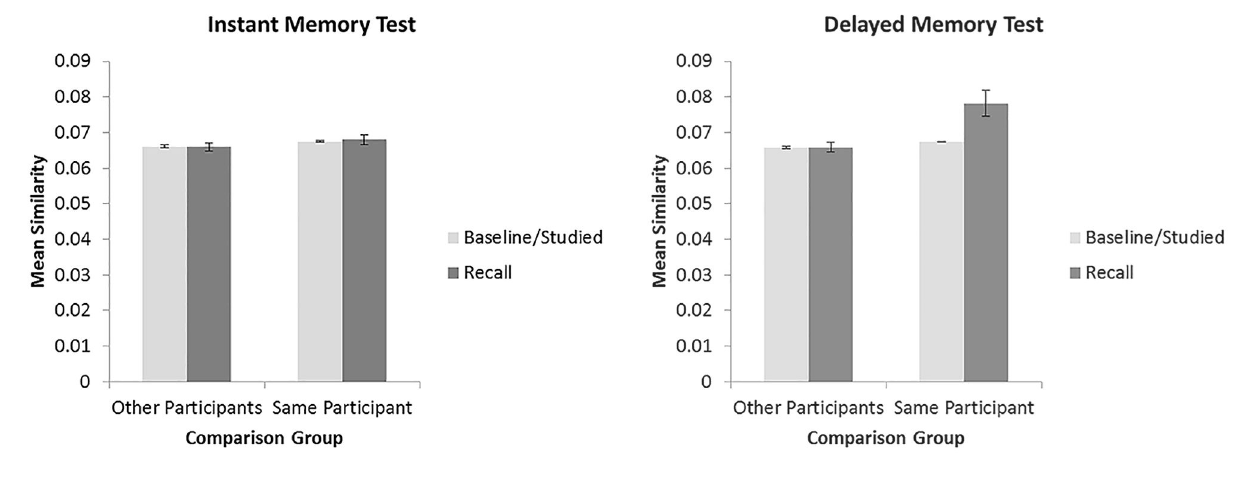
Figure 2. Mean similarity between trials from the same participant or between one participant to other participants for similarity to recall data or similarity to baseline/studied data. Note . Error bars are ± 1 SE